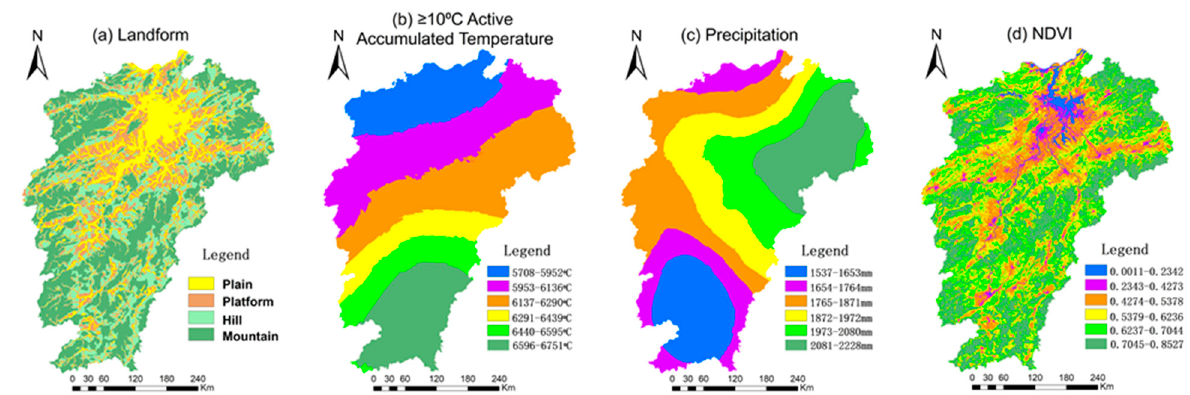
Table 5. Correlation between Ecosystem Services and In fl uencing Factors.